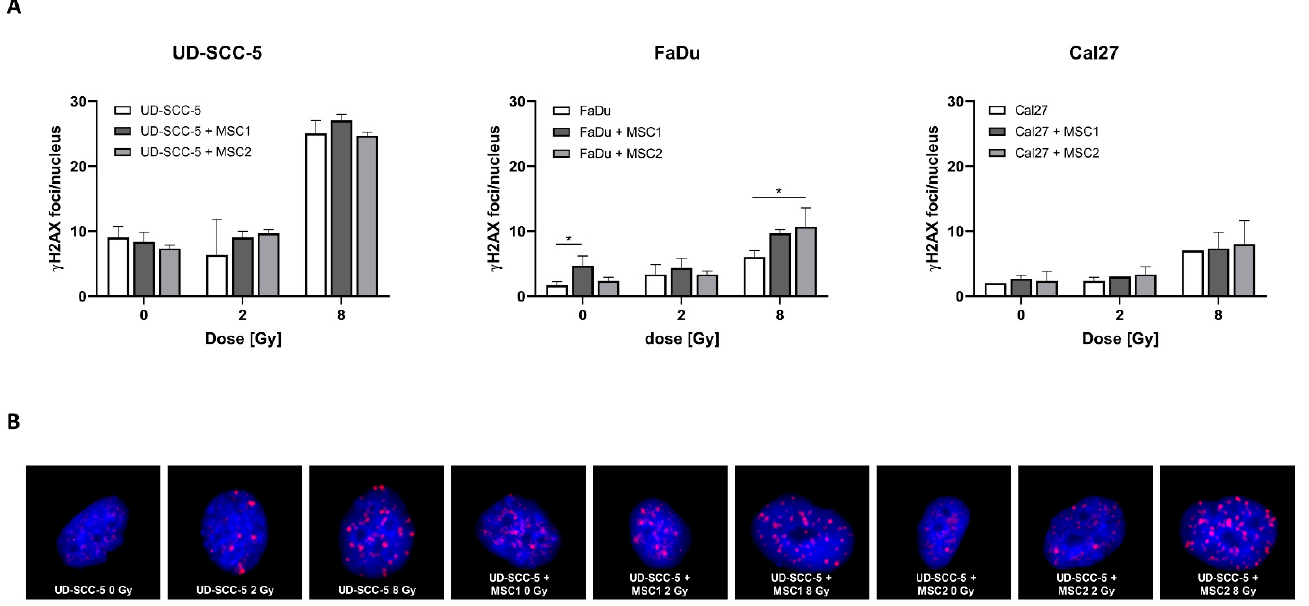
Figure 6. Levels of residual γ H2AX foci after irradiation are largely comparable between HNSCC mono-cultures and HNSCC-MSC co-cultures. ( A ) γ H2AX foci/nucleus in UD-SCC-5, FaDu, and Cal27 cells, either in mono-culture or in co-cultures with MSCs, at 24 h after sham-irradiation or irradiation with 2 Gy or 8 Gy. ( B ) Representative images of UD-SCC-5 cells after sham-irradiation or irradiation with 2 Gy or 8 Gy. For each irradiation dose, the HNSCC-MSC co-culture group was compared with the HNSCC mono-culture using one-way ANOVA with post-hoc Dunnett’s tests. * p < 0.05.